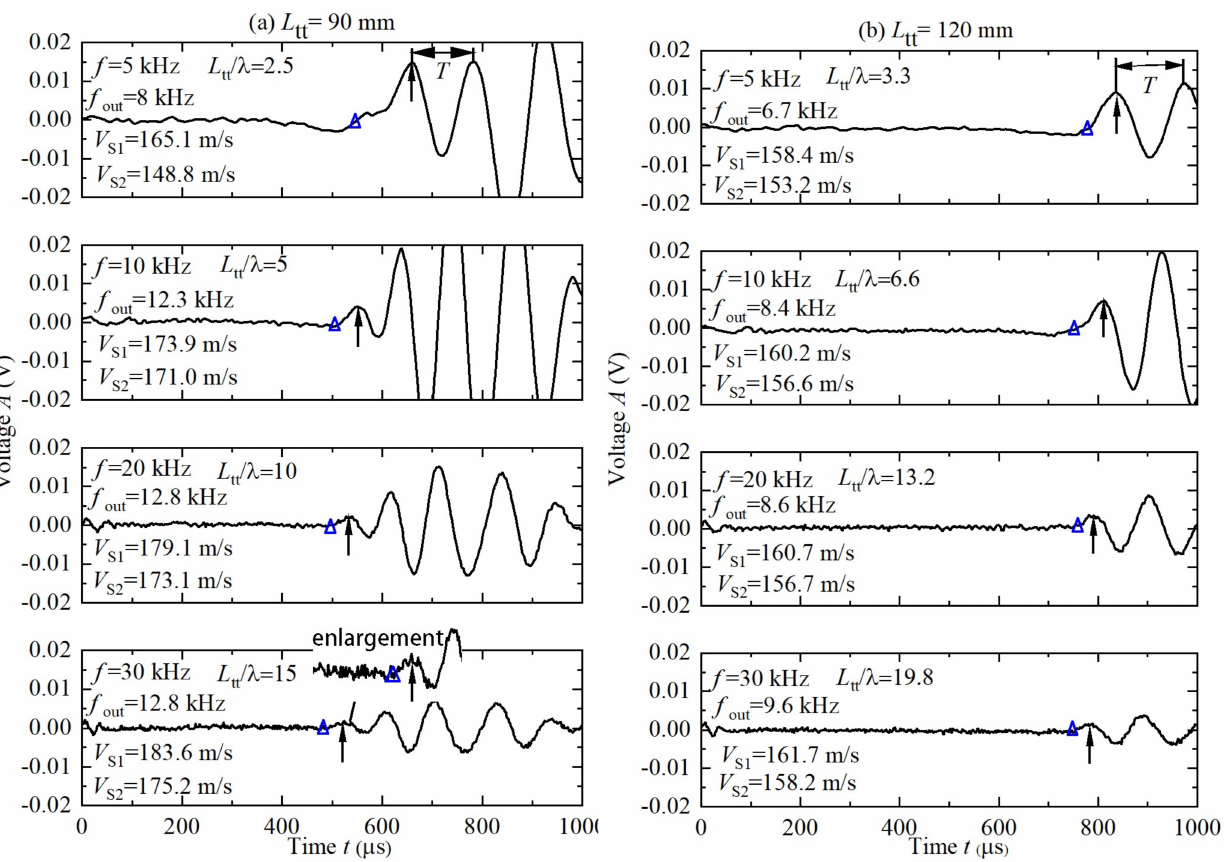
Figure 6. Received waveforms at four testing frequencies: ( a ) L tt = 90 mm; ( b ) L tt = 120